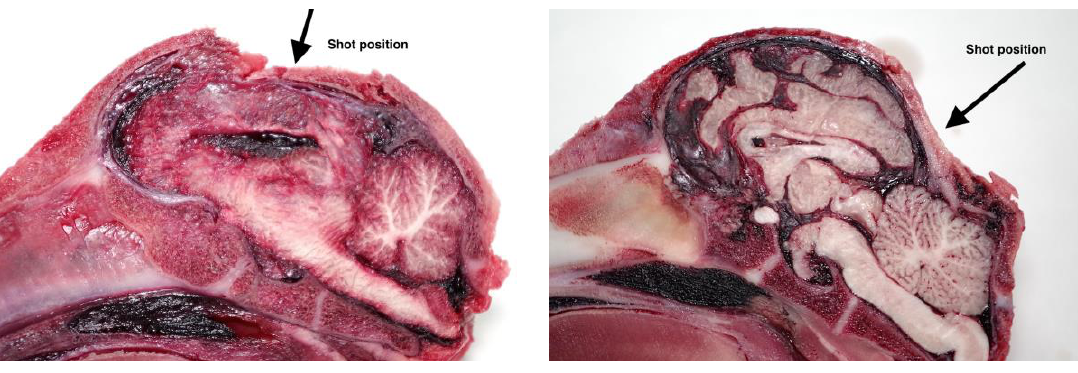
Figure 9. Variation in the damage produced between Kid 9 (forward shot position) and Kid 91 (caudal shot position).